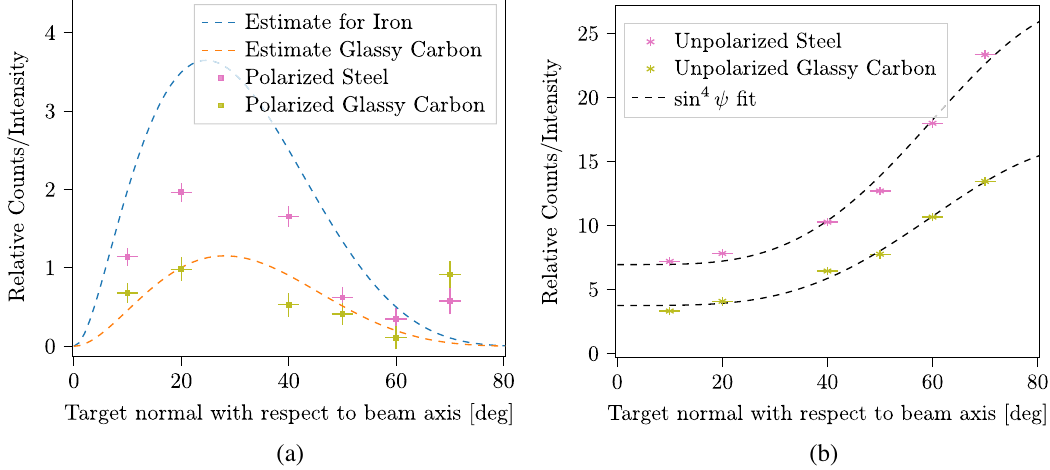
FIG. 14. (a) Detected polarized photons from steel (V2A) and glassy carbon target as a function of polarizer and target angle. (b) Unpolarized photons from steel (V2A) and glassy carbon target as a function of polarizer and target